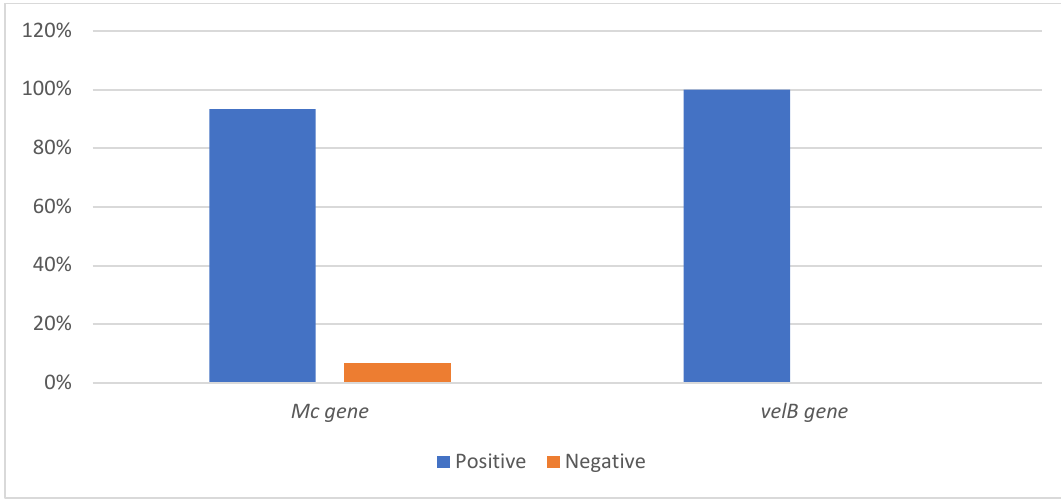
Figure 3. Comparison of M.canis identification using the traditional Mc primers(93.3%) and the new Mc-VelB primers (100%).